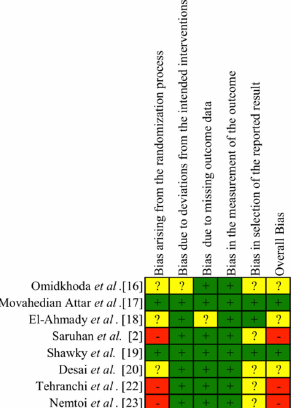
Figure 2. Risk of bias of the RCTs and CCTs studies. + low risk of bias. ? unclear risk of bias. – high risk of